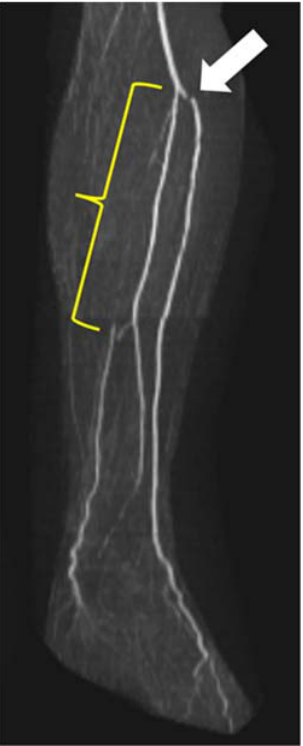
Figure 6. Stenosis in lower leg arteries visualized by QISS ‐ MRA. Long ‐ distance occlusion of the left PT (yellow curved bracket). Note the distal PT, which is refilled by the FA. Harvesting of the fibular artery is prohibited in this case because it is now the main supply to the foot. The white arrow points to a stair ‐ step artifact.